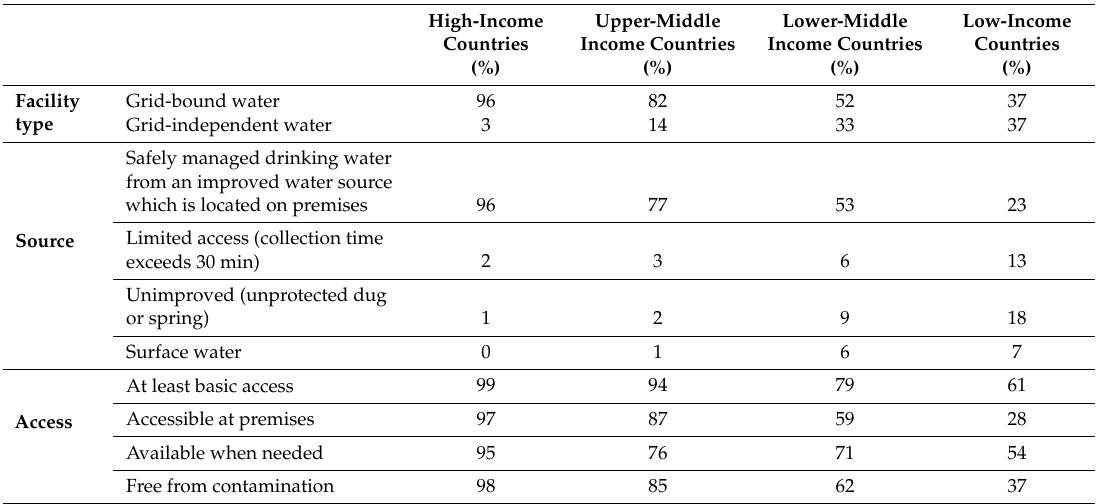
Table 1. Drinking water access and supply in different world regions (sources: [31], country list according to